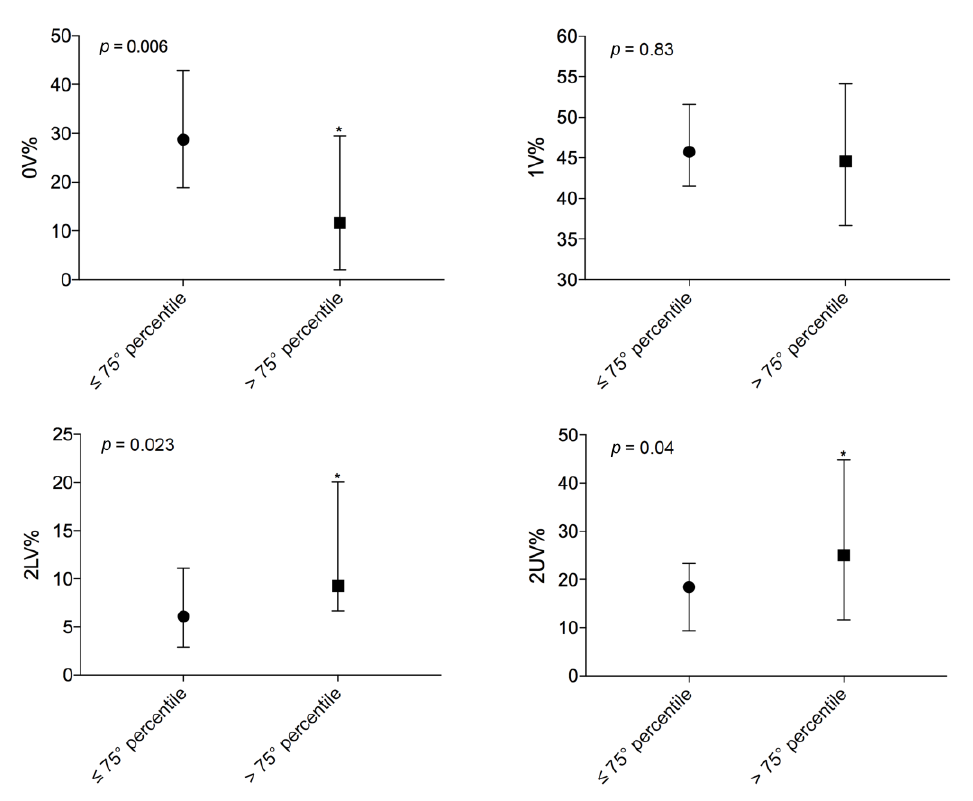
Figure 3. Comparison of autonomic parameters evaluated by symbolic analysis between patients on the lung transplant list with a LAS lower than or equal to the 75th percentile ( n = 37) and patients on the transplant list with a LAS above the 75th percentile ( n = 12); *, statistically significant.